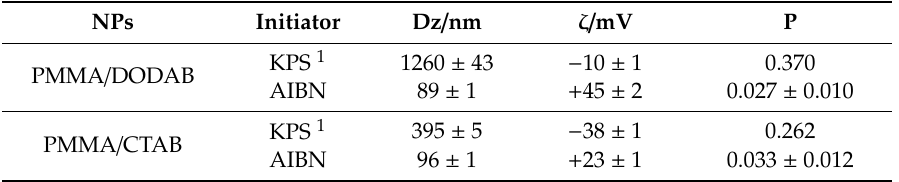
Table 4. Comparison between nanoparticles of PMMA / QAC synthesized using either potassium persulfate (KPS) or azobisisobutyronitrile (AIBN) as initiators, at 0.56 M MMA and 2 mM